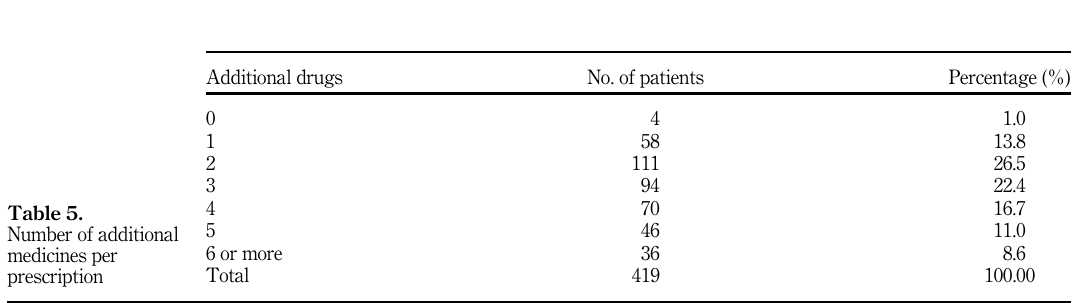
Table 4. Frequency of daily PPIs administration on different conditions requiring PPI prescription as per the prescription